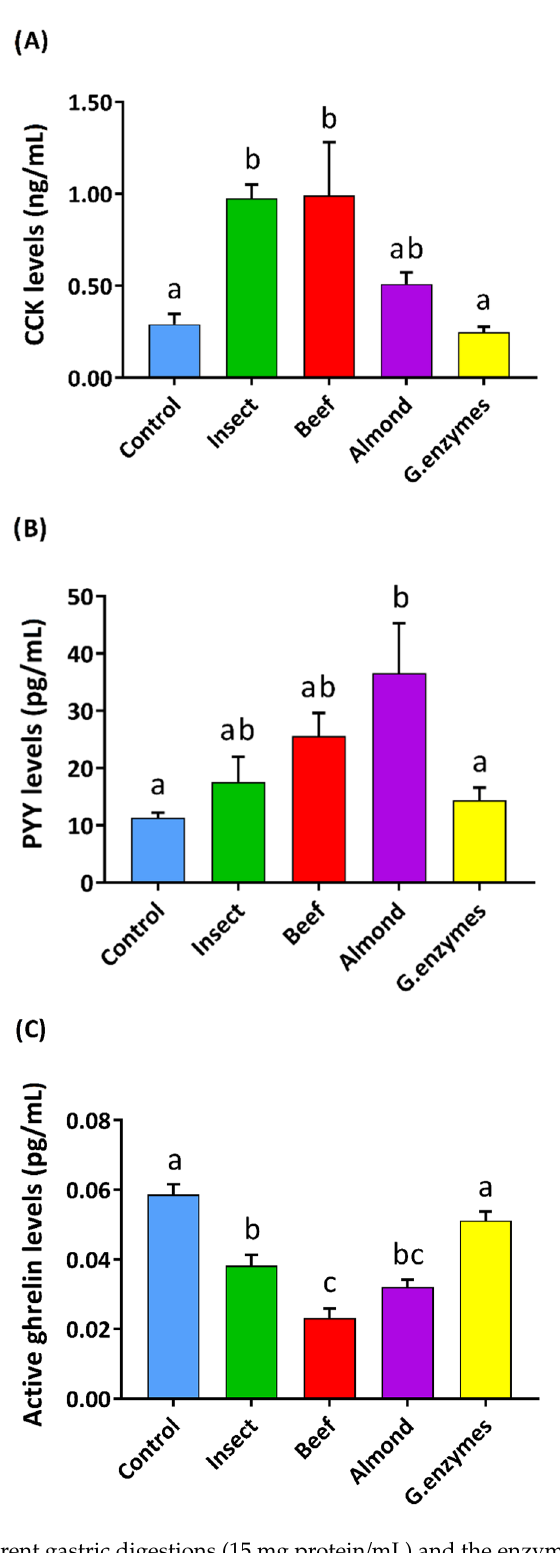
Figure 2. Effect of different gastric digestions (15 mg protein/mL) and the enzyme control on CCK ( A ), PYY ( B ), and active ghrelin ( C ) pig duodenum secretion in explants. The incubation period was 60 min for CCK and PYY and 90 min for active ghrelin secretion, all after 15 min of stabilization. The sample size was control (KRB buffer with D-glucose 10 mM) n = 9, treatments n = 6. Results are expressed as the mean ± SEM. One-way ANOVA and Tukey’s post-hoc test were used for multiple comparisons. Different letters (a, b, c) indicate significant differences ( p -values < 0.05).